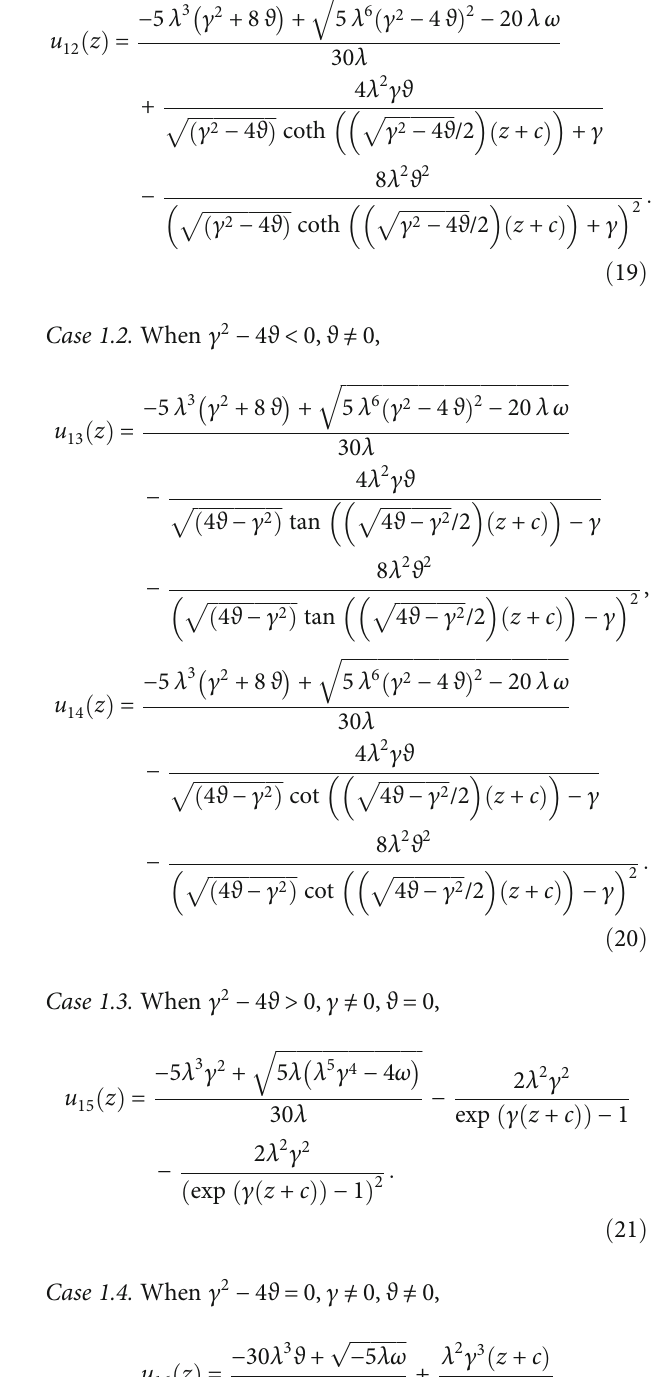
ffiffiffiffiffiffiffiffiffiffiffiffiffiffiffiffiffiffi ffiffiffiffiffiffiffiffiffiffiffiffiffiffi ffiffiffiffiffiffiffiffiffiffiffiffiffiffiffiffiffiffi γ 2 − 4 ϑ ð coth